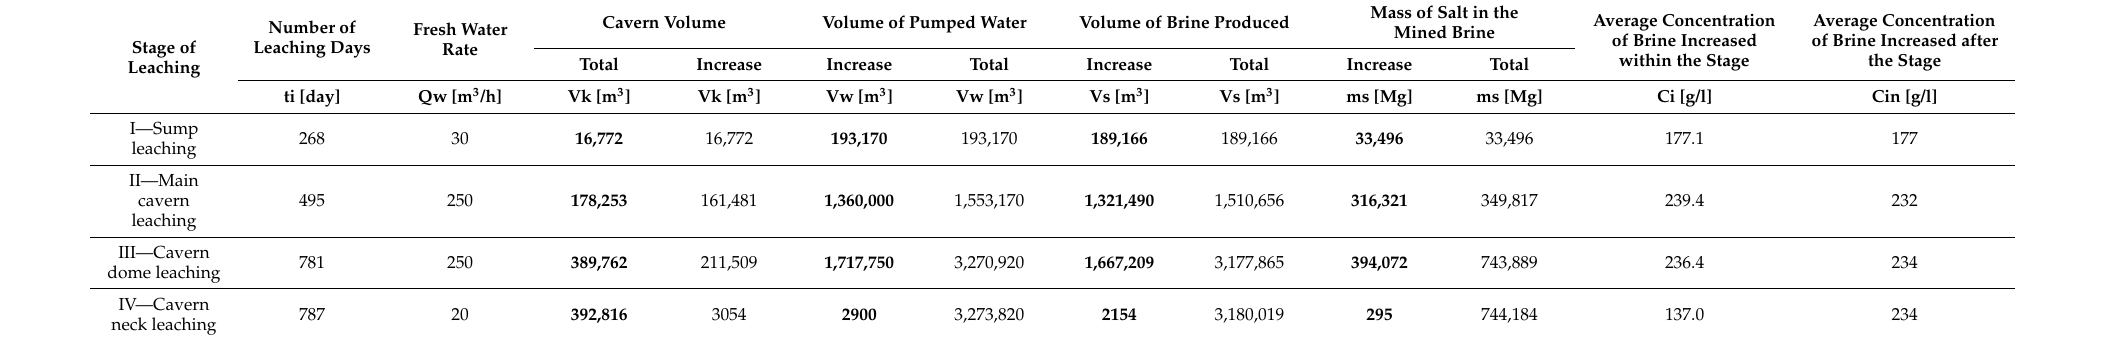
Table 3. Development of the leaching process of a classic storage